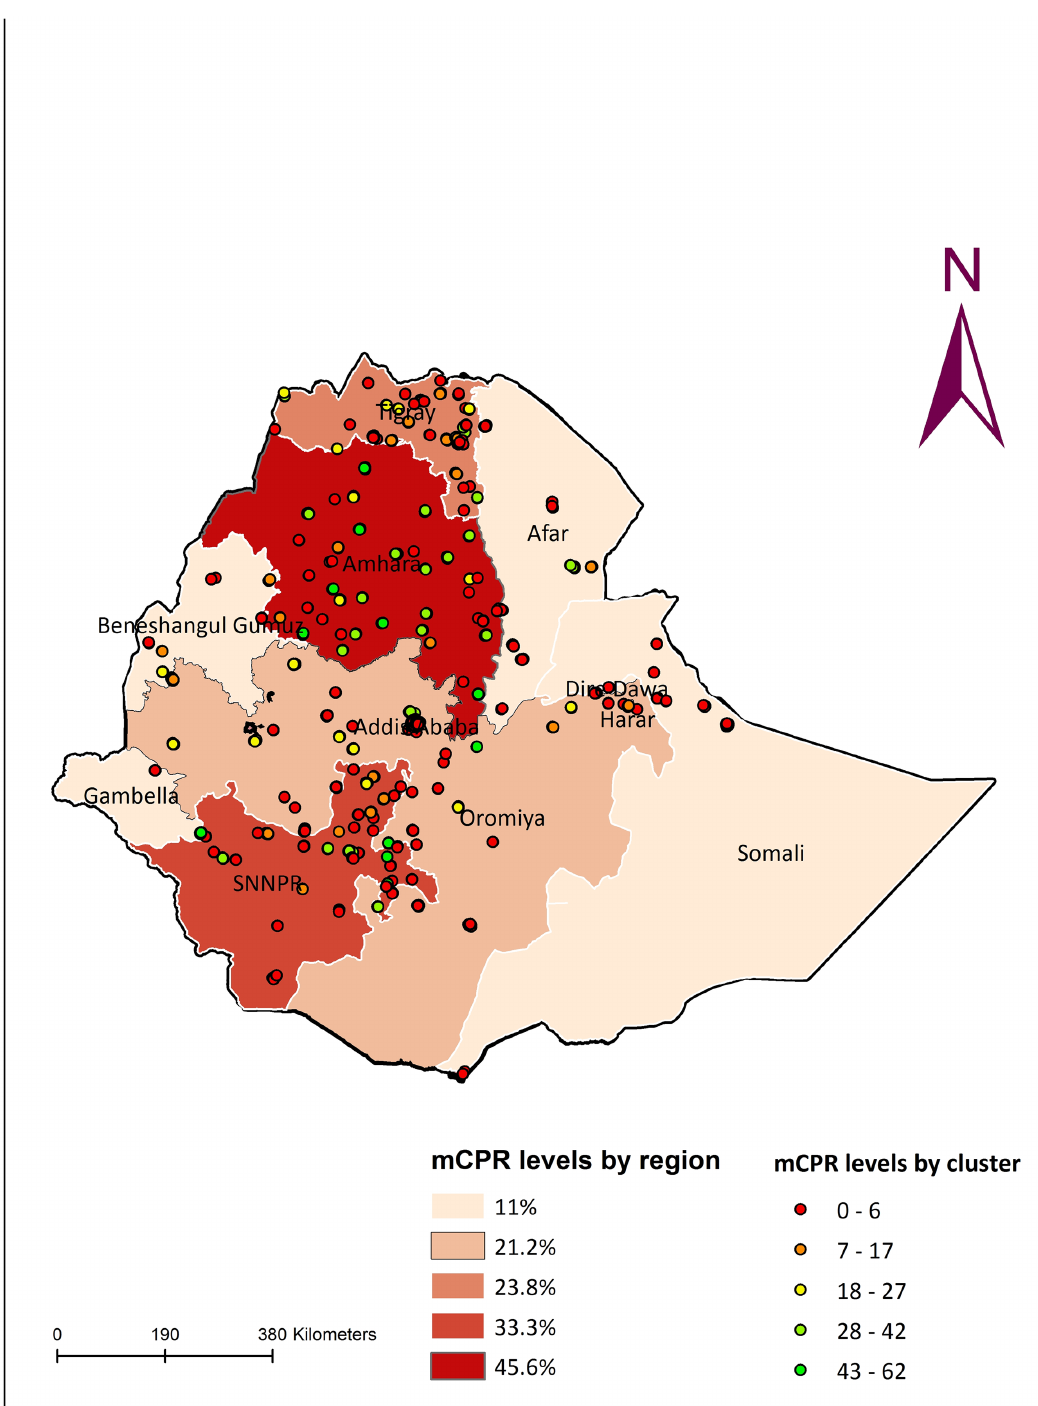
Fig 3. Spatial distribution of clusters with high and low rates of mCPR and regions according to levels of mCPR, 2014.